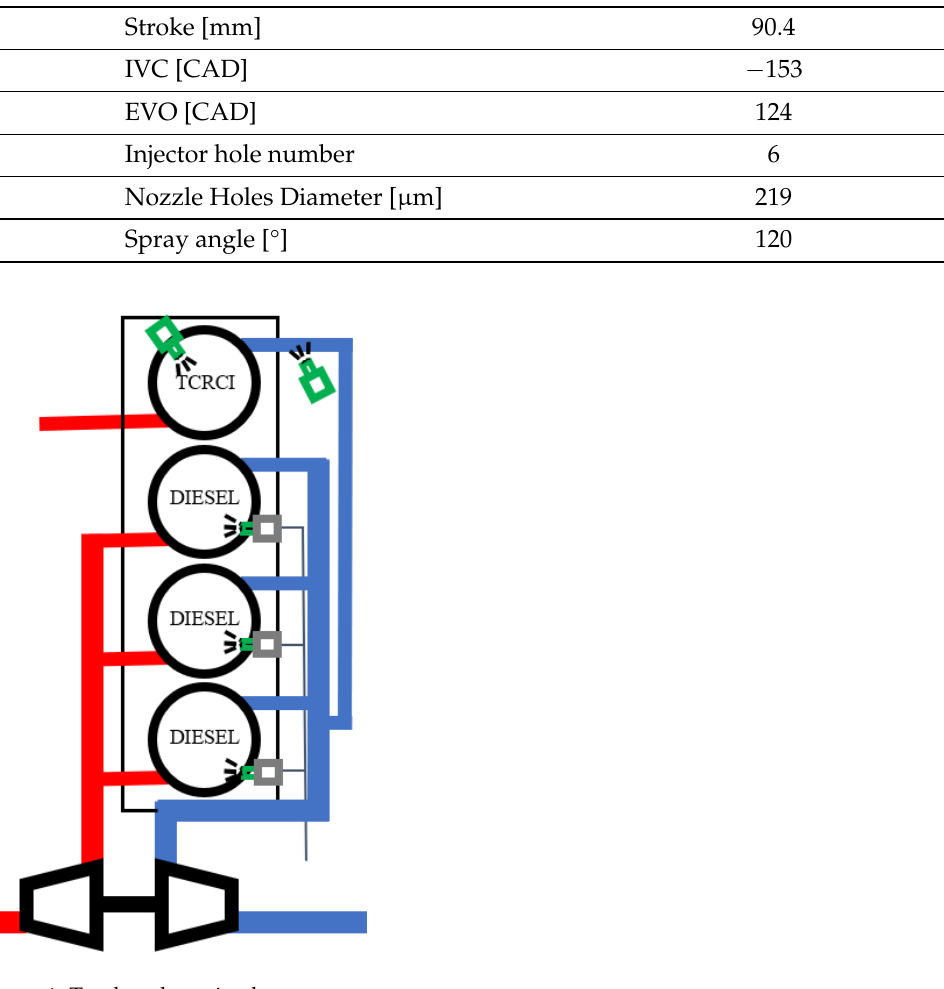
Figure 1. Test bench engine layout.